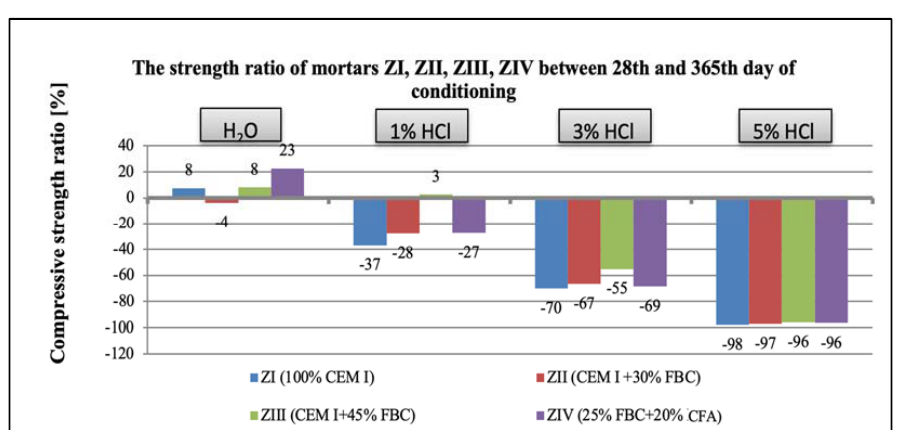
Figure 32. Compressive-strength ratio of mortars ZI, ZII, ZIII, and ZIV between the 28th and 365th day of conditioning in water and in 1%, 3%, and 5% solutions of hydrochloric acid.